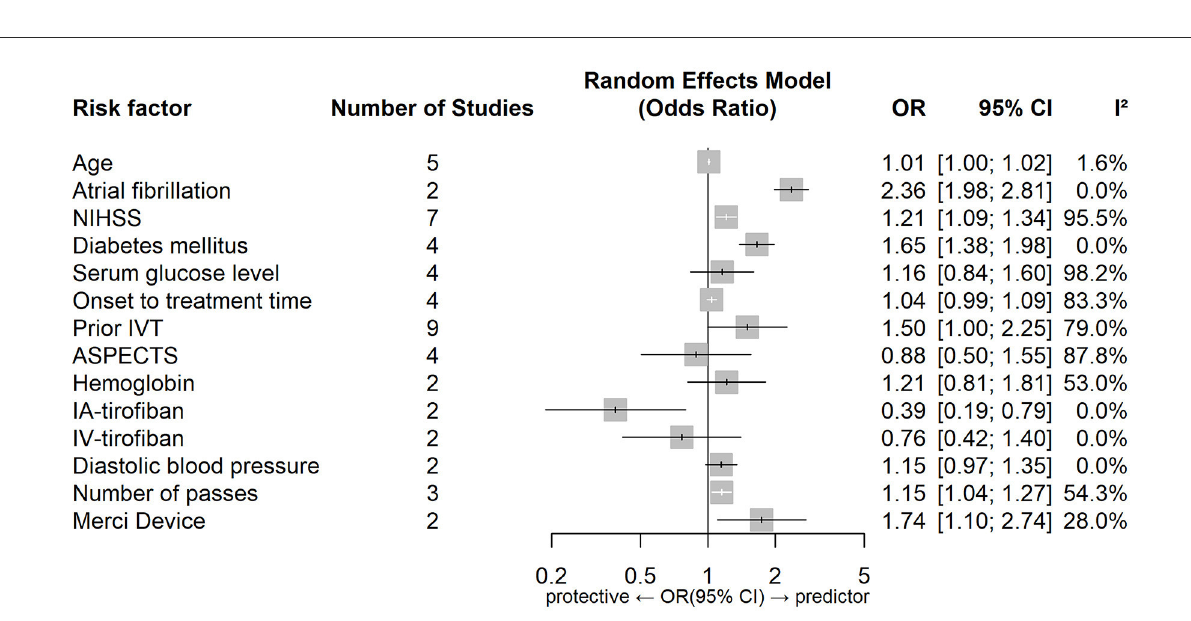
FIGURE3 Forest plot of predictors for any ICH after EVT. OR, Odd Ratio; CI, Confidence Interval; NIHSS, National Institute of Health Stroke Scale; IVT, Intravenous Thrombolysis; ASPECTS, Alberta Stroke Program Early CT Score; IA, Intraarterial; IV,